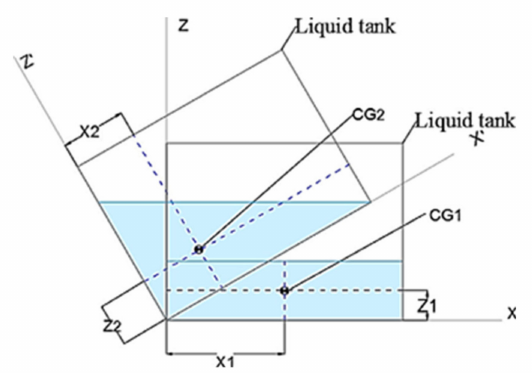
Figure 4 : Liquid shift and center of gravity (CG 1 , CG 2 ) position [75]. Figure 4. Liquid shift and center of gravity (CG 1 , CG 2 ) position [75].